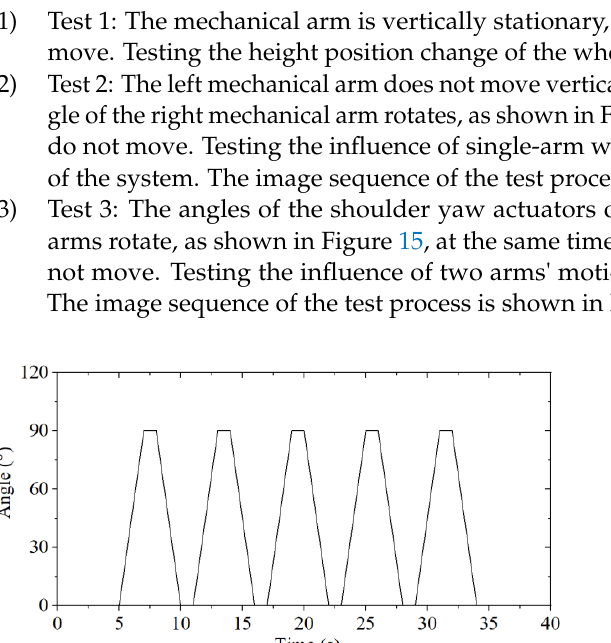
Figure 14. Analysis of position trajectory changes in cooperative dual-arm manipulation test.